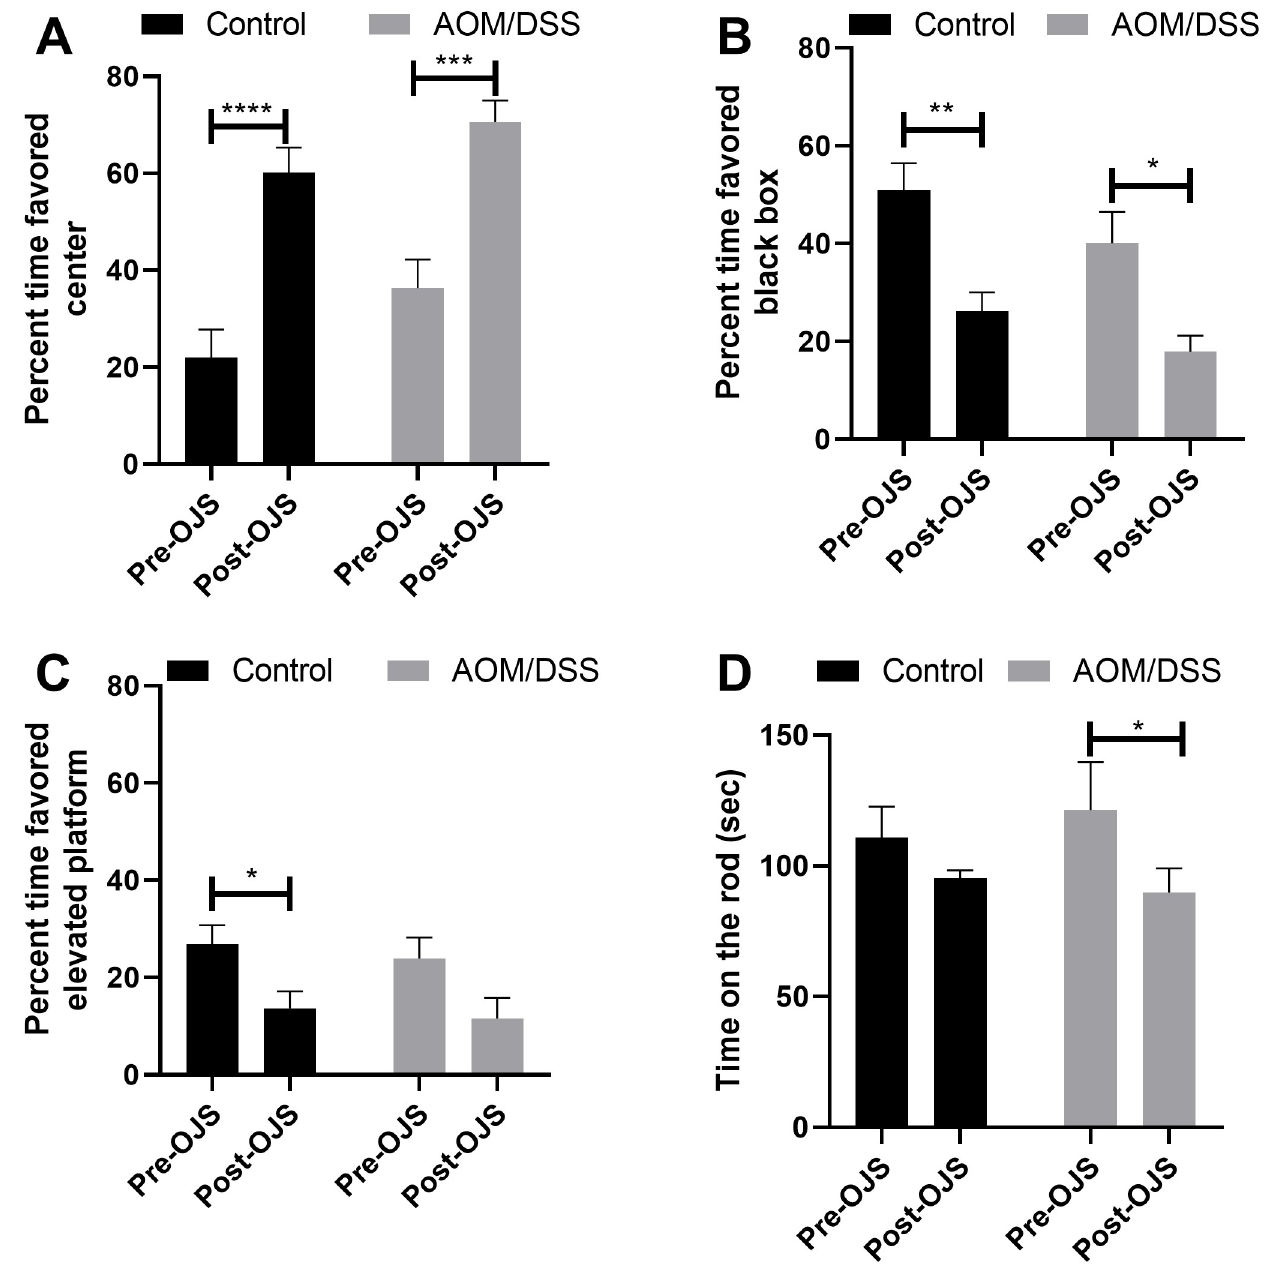
Fig 5. OJS exhibits sedative properties in the AOM/DSS model. Exploratory behavior was assessed using a custom acrylic box with two distinct compartments. Percent time that the mice spent in (A) center, (B) black box, and (C) elevated platform were evaluated at baseline (pre-OJS) and after OJS (post-OJS) administration. n = 17 Control non-cancer mice and n = 13 AOM/DSS mice. � Indicates statistical significance between groups (p < 0.05) from Mixed-effects model (REML) Sidak post hoc. (D) Neuromuscular performance in rotarod test from pre-OJS to post-OJS treatment. n = 8 Control non- cancer mice and n = 8 AOM/DSS mice. � Indicates statistical significance between groups (p < 0.05) from two-way RM ANOVA Fisher LSD post hoc. https://doi.org/10.1371/journal.pone.0270338.g005 To evaluate whether OJS possessed sedative properties we utilized the rotarod test. The rotarod test measures neuromuscular function and it is classically used to examine sedative properties of drugs. For this test, we acclimated the mice to the rotarod and then performed the test 10 min after oral gavage with water (Vehicle) or OJS (Fig 5D). No statistical difference